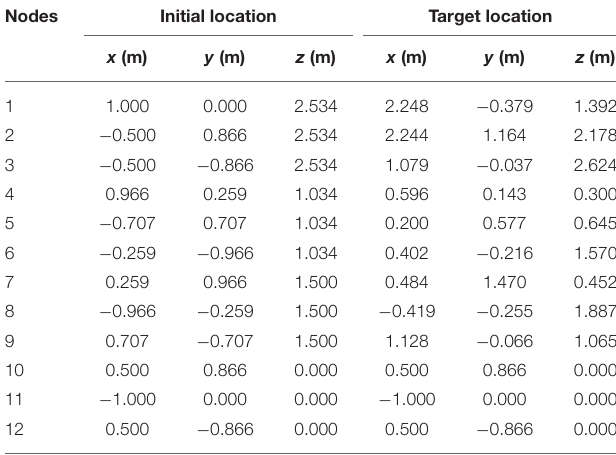
TABLE 1 | Nodal coordinates of the double-layered tri-prism tensegrity